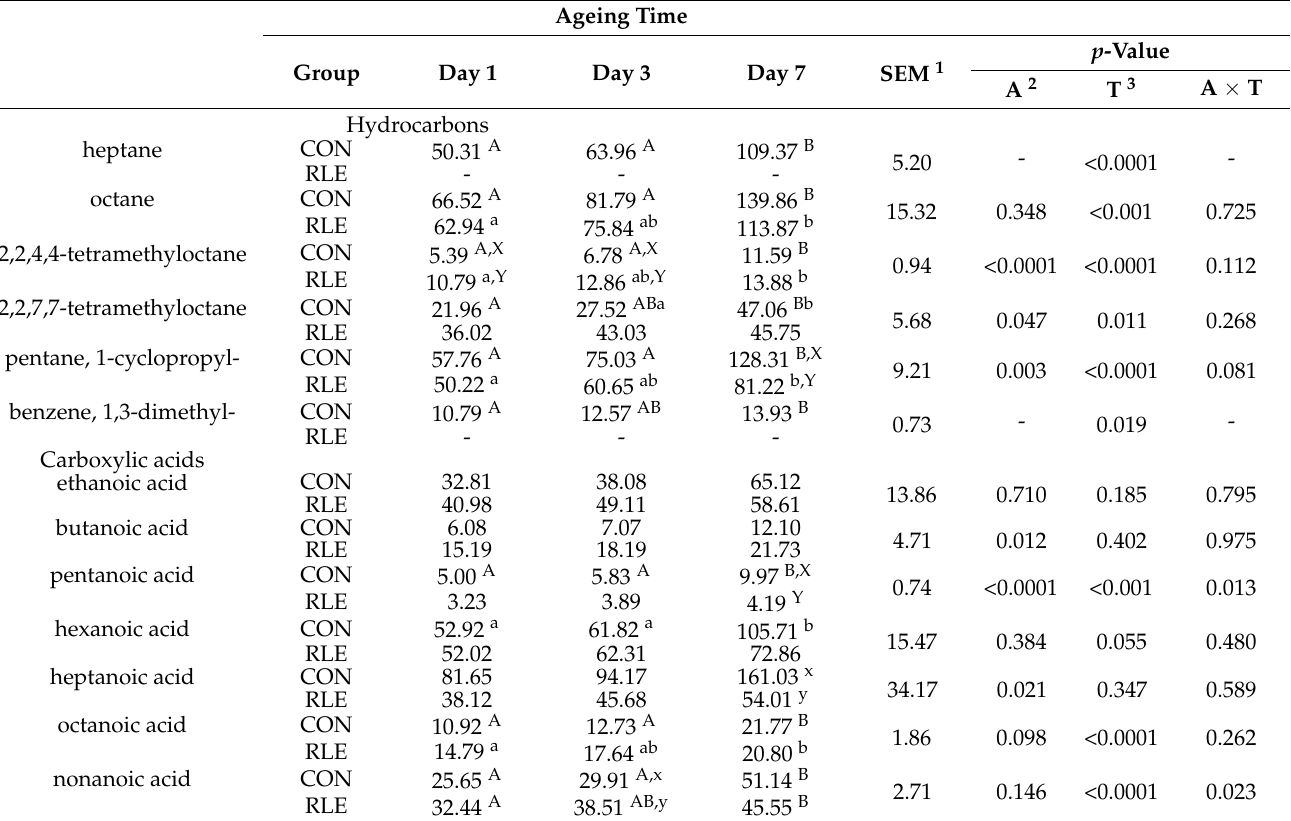
Table 6. Effects of anthocyanin diet addition and ageing on hydrocarbon and carboxylic acid volatile compounds of meat from goat kids ( n = 30 samples for each experimental group). Results are expressed as ng/g of